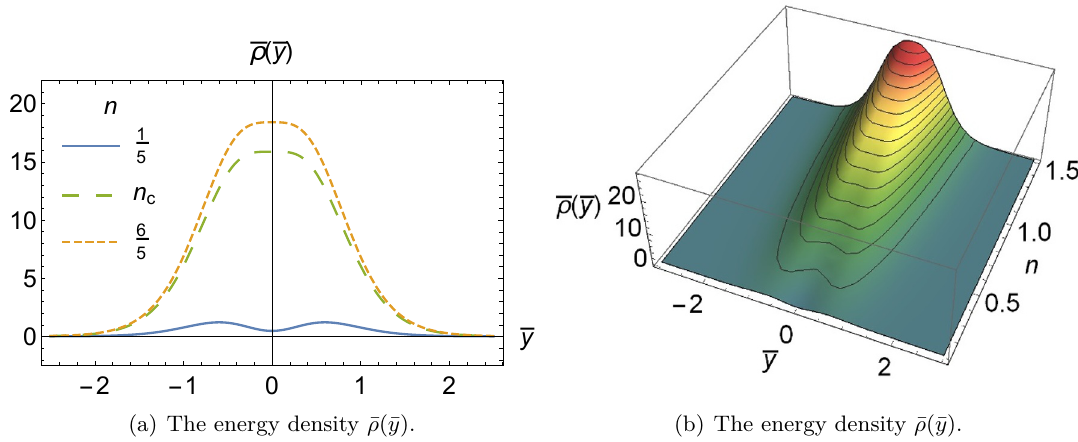
Figure 9 . Plots of the dimensionless energy density ¯ ρ (¯ y ) in eq. (5.23). The blue solid line and the orange dashed line represent the split and non-split energy densities, respectively. The green long dashed line represents the critical line of energy density